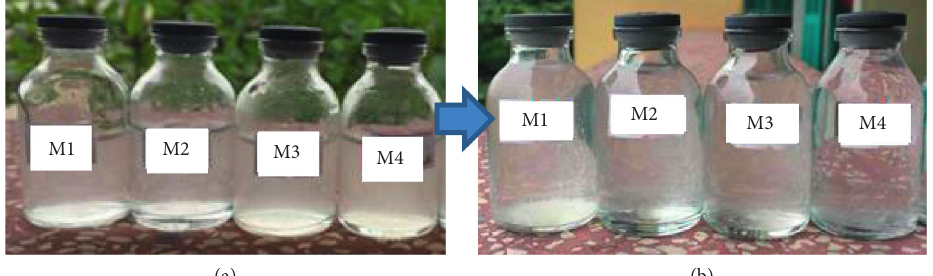
Figure 7: Chitosan solution at different CTS/TPP ratios before filtration with distilled water (a) and nanochitosan solution at different CTS/ TPP ratios after filtration with distilled water (b).